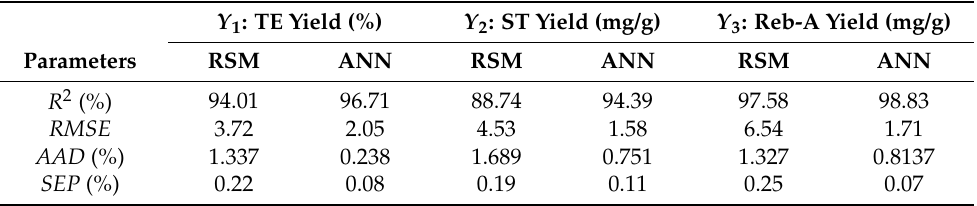
Figure 5. Comparison between the experimental values and model − predicted data values that were rendered by the RSM model for: TEY (%) ( A ) ST yield (mg/g) ( B ) and Reb − A yield (mg/g) ( C ); ANN model for: TEY (%) ( D ), ST yield (mg/g) ( E ), and Reb − A yield (mg/g) ( F ), Scatter plot showing the distribution along the straight line of predicted values versus the experimental values that were obtained by ANN and RSM models for the prediction of: TEY (%) ( G ), ST yield (mg/g) ( H ), and Reb − A yield (mg/g) ( I ). Table 4. Predictive comparison parameters showing the estimation comparison of the RSM and ANN models for the three target